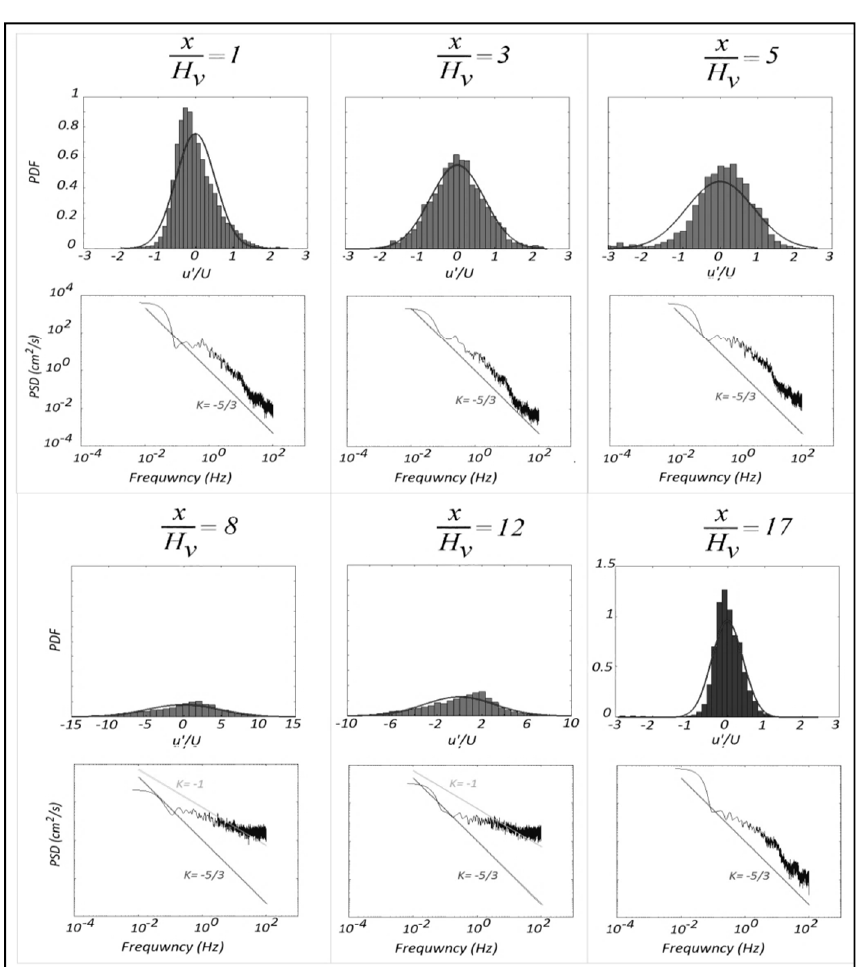
Figure 10. Probability density function and the turbulent spectra for the mixing layer of Case 1.